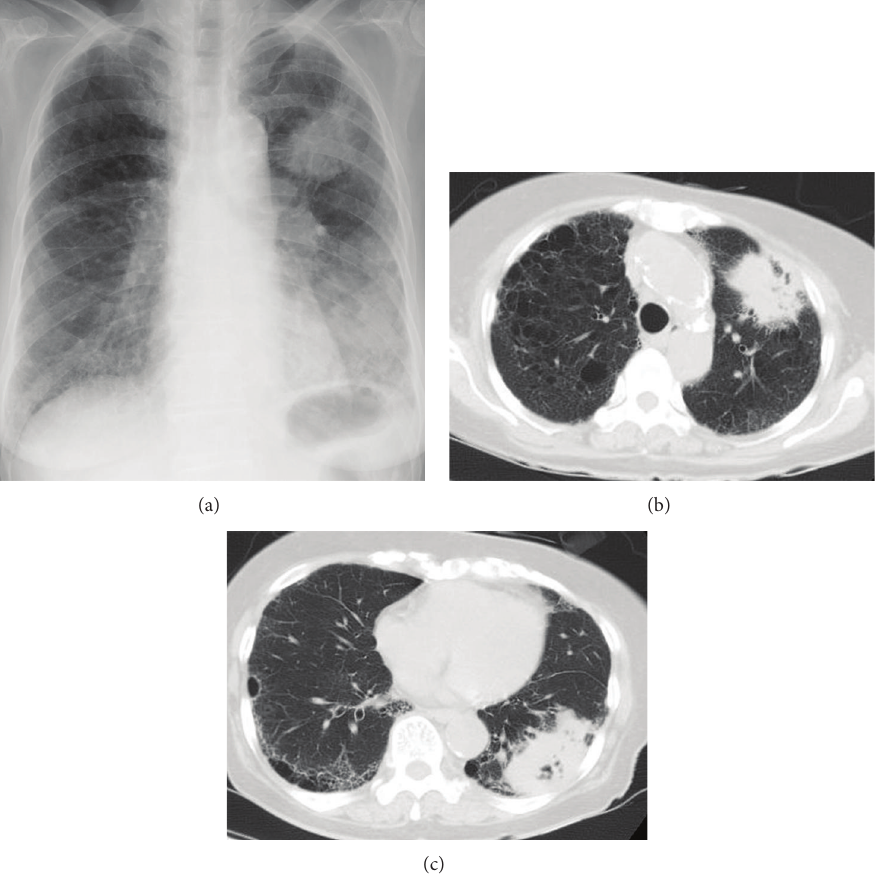
Figure1:Chestradiographyrevealinga5 cmmassintheupperlungfield(a).Chestcomputedtomography(CT)revealinginterstitialshadows in both lungs. Chest CT also revealed a 5.2 cm irregular mass with cavity and speculated margin in right S3 and a 7.6cm irregular mass with cavity and air bronchogram sign, which are adjacent to the pleural walls ((b) and